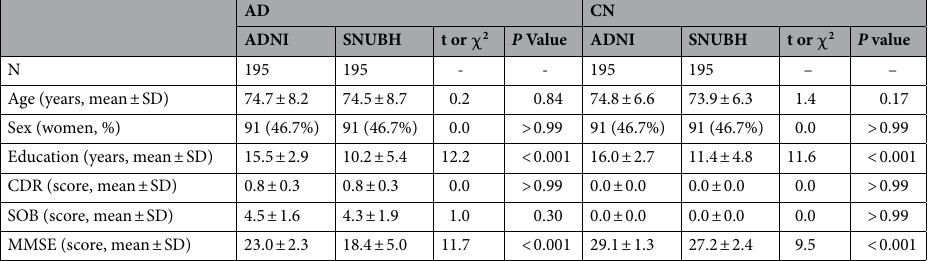
Table 3. Characteristics of participants. AD Alzheimer’s disease, CN cognitively normal, ADNI Alzheimer’s Disease Neuroimaging Initiative, SNUBH Seoul National University Bundang Hospital, SD standard